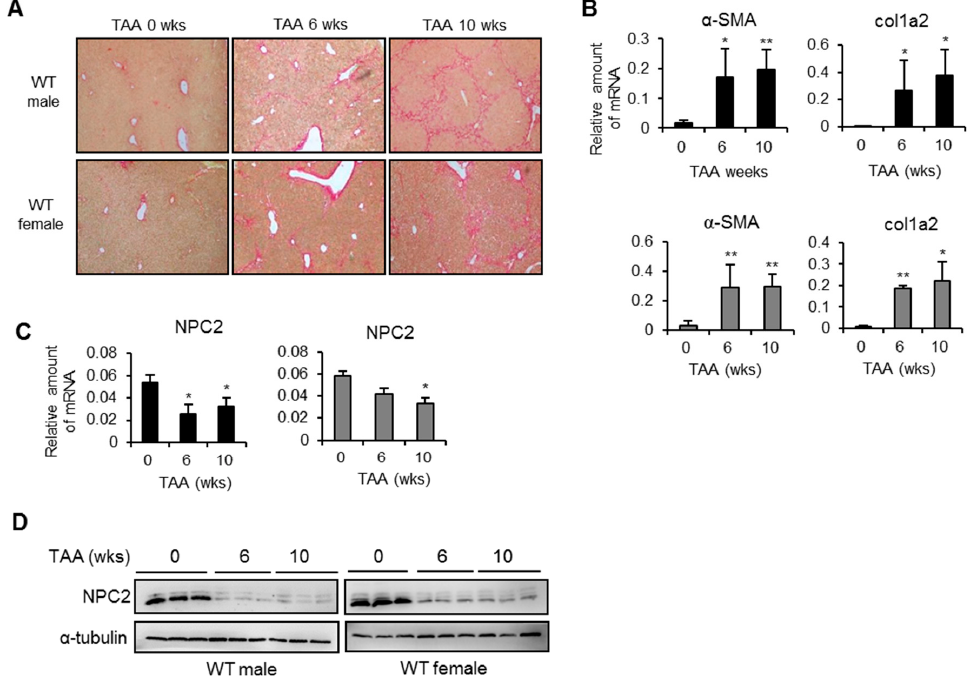
Figure 1. Niemann-Pick type C2 (NPC2) is down-regulated in thioacetamide (TAA)-induced liver fibrosis tissues. ( A ) Representative sirius red staining images of liver tissues from mice treated with TAA for 0, 6, and 10 weeks. Original magnification, ×100; ( B , C ) Results from Q-PCR analyses of α -smooth muscle actin ( α -SMA), collagen type 1 α 2 (Col1a2), and NPC2 gene expression in TAA-treated wild-type (WT) male (black bar) and WT female (gray bar) mice; ( D ) Representative results from Western blot analyses of NPC2 expression in TAA-treated WT mice. n = 5 per group. Data are shown as mean ± SD. * p < 0.05; ** p < 0.01 vs. no TAA treatment.